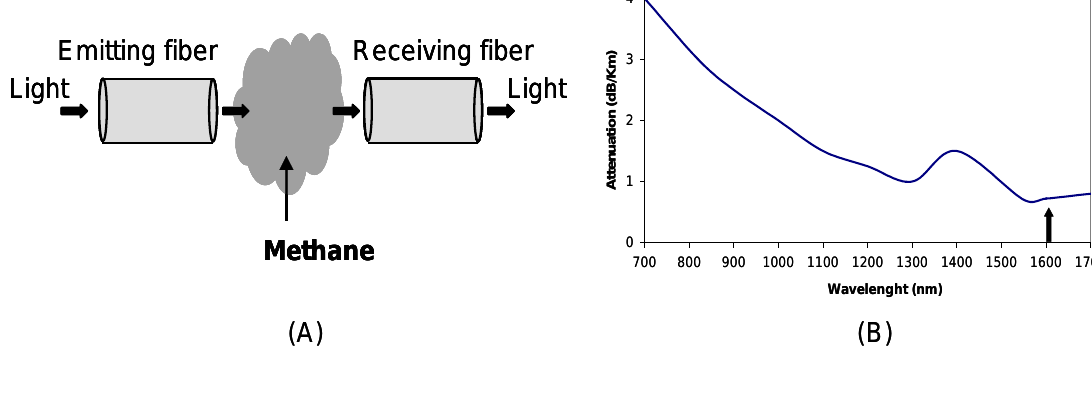
Figure 4. (A) Extrinsic optical fiber sensor; (B) One of the absorption spectral lines of methane is located at a optical fiber low transmission losses wavelength range (third telecommunication